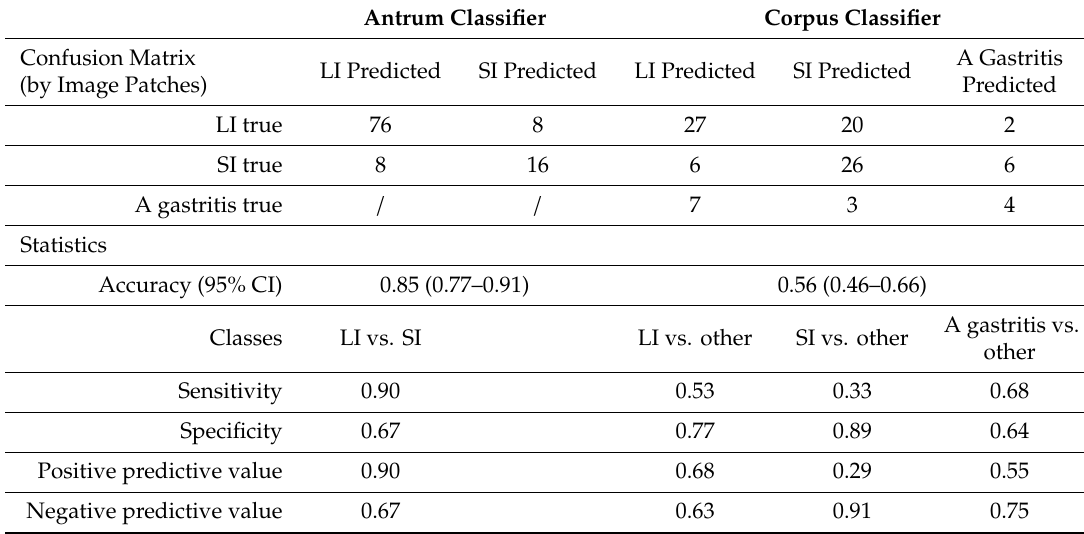
Table 3. Antrum and corpus classifier confusion matrix and statistics for the test image patch set. Antrum Classifier Corpus